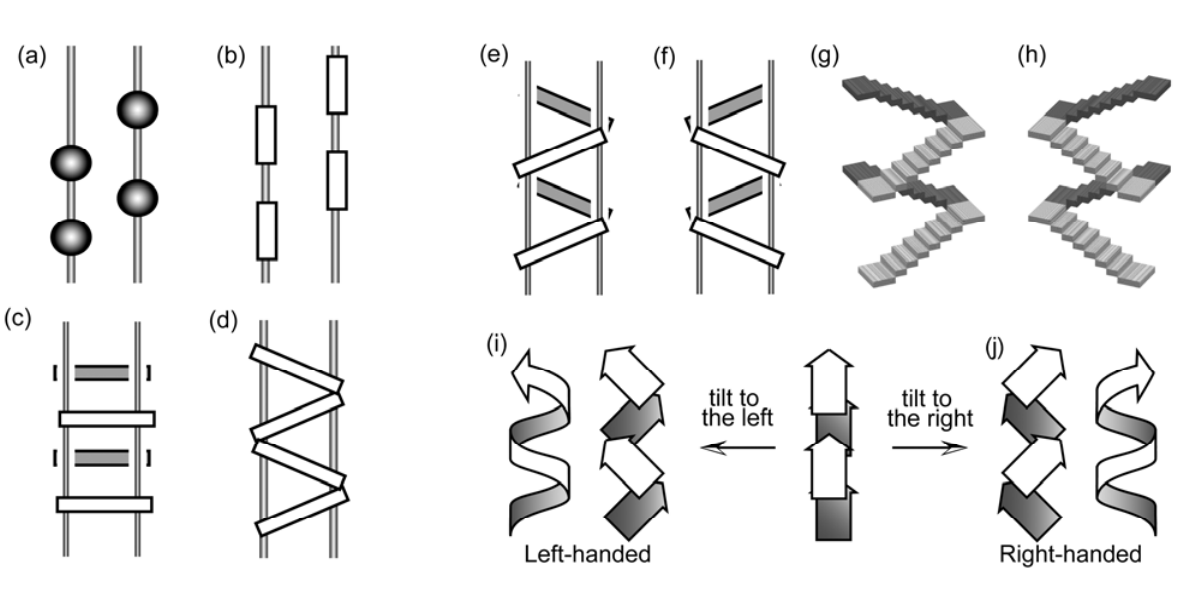
Helical assemblies of spheres (a), Figure 12. Helical chirality based on tilt chirality. 2 1 bars parallel to a 2 axis (b), bars perpendicular to a 2 axis (c), bars with a zigzag 1 1 arrangement (d), bars with right-tilt arrangement (e) and a left-tilt arrangement (f), right- handed stairs with tilt chirality (g), left-handed stairs with tilt chirality (h). Definition of helical assemblies of planar molecules with left-handedness (i) and handedness of the 2 1 right-handedness